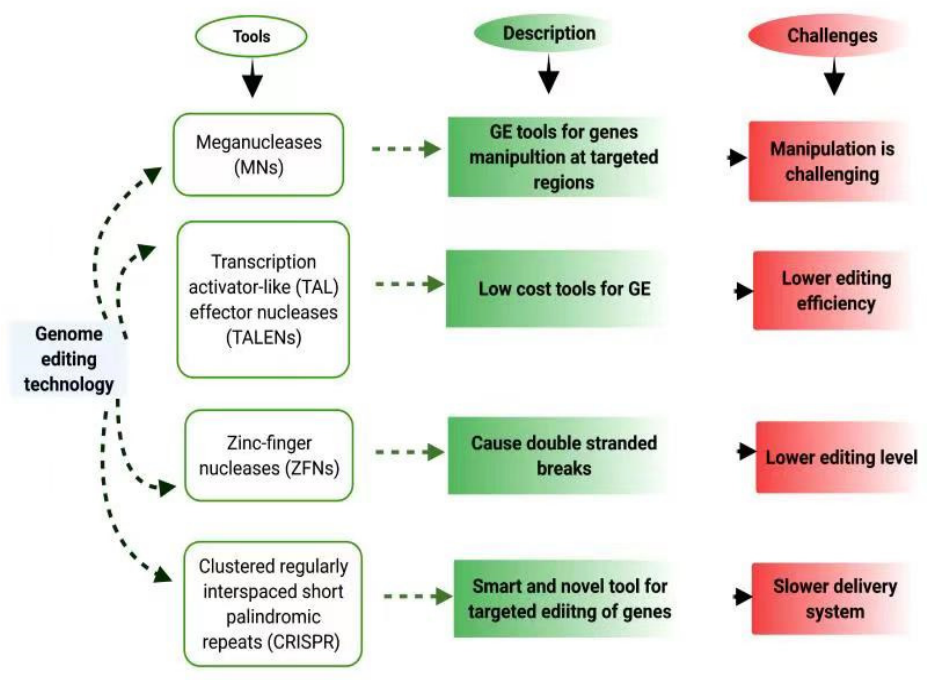
Figure 2. A comparison of genome editing tools. Comparison of these tools shows their efficiency towards genome editing and also shows their limitations. Hence CRISPR/Cas9 technique is more accurate than other tools. Table 2. Differences in functions of genome editing tools.